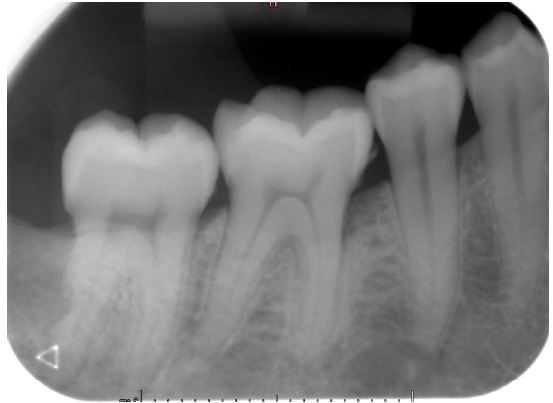
Figure 7. Intraoral X-ray of case #2 at one-year follow-up exam. Case